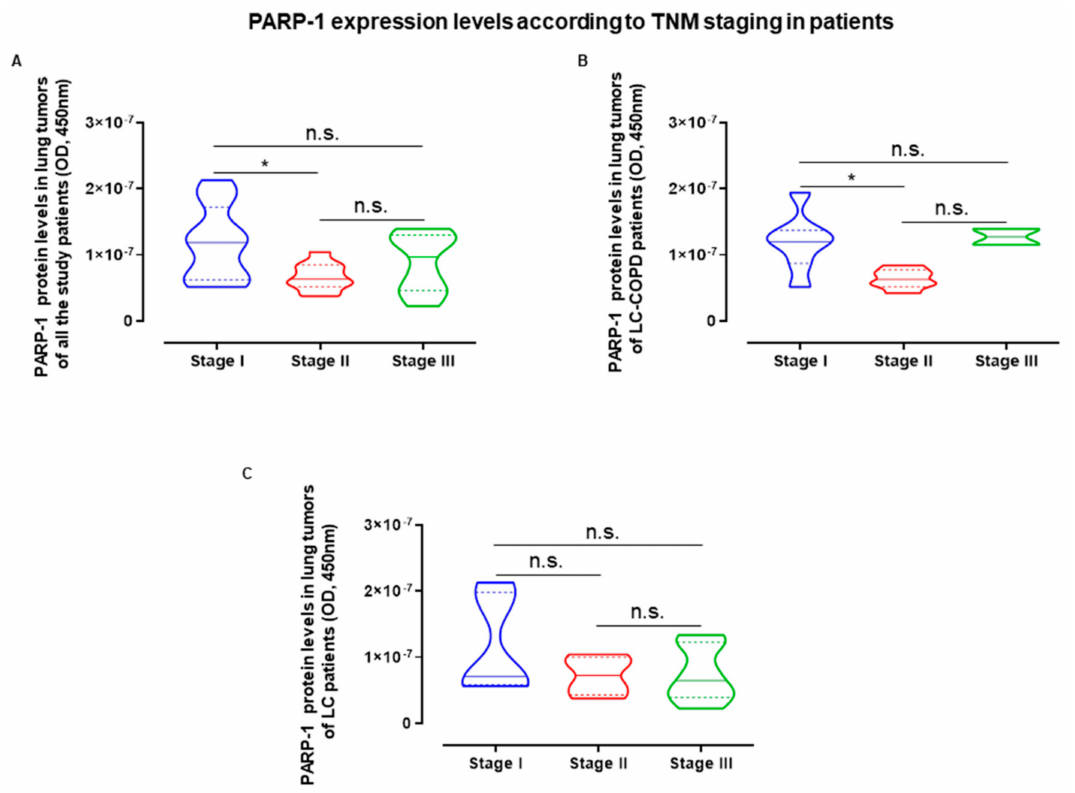
Figure 5. ( A – C ) Violin plots with median (continuous lines) and interquartile ranges (discontinuous lines) of PARP-1 protein levels in lung tumors according to cancer stages in all the study patients, LC-COPD and LC patients respectively. Statistical significance: * p < 0.05, n.s., no significance among cancer stages of patients. Definition of abbreviations: PARP, poly-ADP ribose polymerase; OD, optical